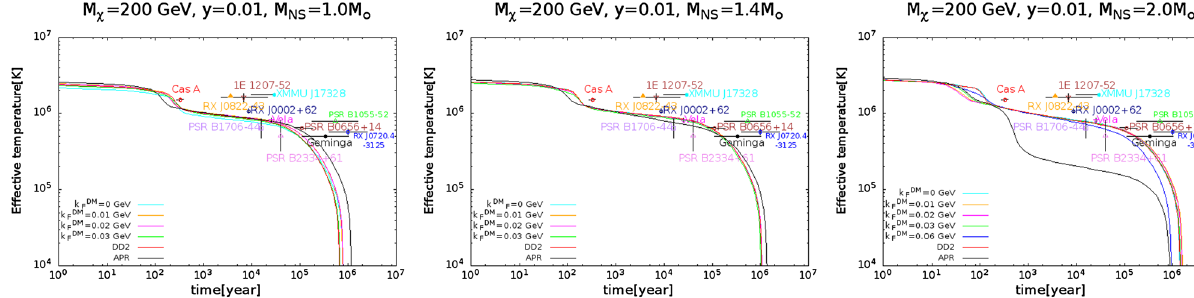
Fig. 7 Variation of effective temperature with time for three differ- ently chosen NS masses M NS = 1 . 0 M (cid:8) (Left panel), M NS = 1 . 4 M (cid:8) (middle panel), M NS = 2 . 0 M (cid:8) (right panel) with varying k DM fixed M χ = 50GeV in each panel. The theoretical calculations are